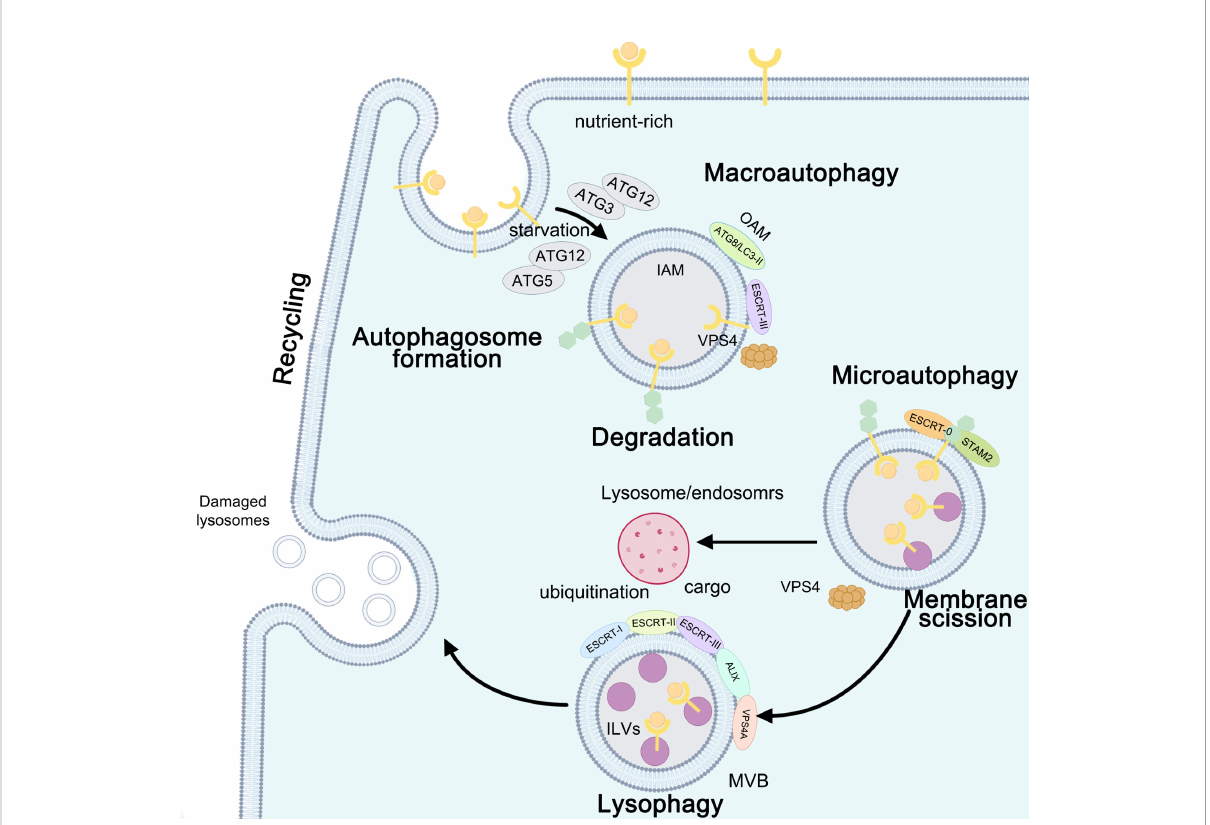
FIGURE 2 Autophagy: the function between ESCRT and macroautophagy, microautophagy, and lysophagy. ESCRT-III- and VPS4-induced macroautophagy is involved in the formation of autophagosomes: ATG12-ATG5 is needed under starvation conditions, while ATG12-ATG3 is required under nutrient-rich conditions. Upon closure, ATG8/light chain 3 (LC3)-II on the outer autophagosomal membrane (OAM) is delipidated and released to the cytosol, while LC3-II associated with the inner autophagosomal membrane (IAM) is degraded upon autophagosome-lysosome fusion. ESCRT-0- and signal transducingadaptor molecule 2 (STAM2)-initiated microautophagy requires membrane scission. ESCRT-I, ESCRT-II, ESCRT-III, ALIX, and VPS4A are recruited to damaged lysosomes and precede